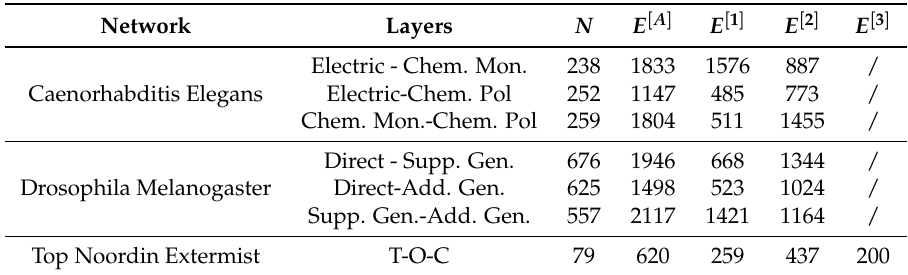
Table 1. The basic information of the real multiplex networks. The first column represents the names of the different multiplex networks and the second column identifies the names of different layers used to construct multiplex networks. The other columns contain information about the number of nodes N , the total number of edges in the aggregated network of each multiplex network E [ A ] and the number of edges in each layer ( E [ 1 ] , E [ 2 ] and E [ 3 ]